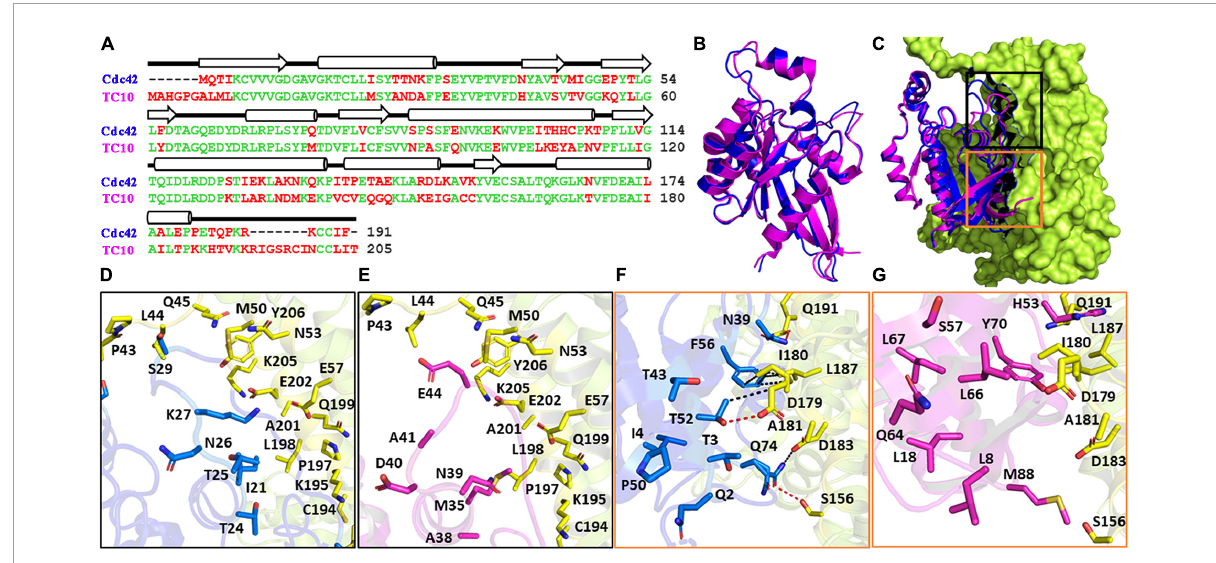
FIGURE1 Cdc42 and TC10 comparison. (A) Sequence alignment calculated with Clustal (Sievers et al., 2011) of murine TC10 and Cdc42. Conserved amino acid residues are displayed in green, diverging residues in red. On the top, β -strands (arrows) and α -helices (cylinders) are indicated. (B) Superimposition of Cdc42 (PDB entry 1an0; blue) and TC10 (PDB entry 2atx; magenta), highlighting their conserved three-dimensional structures. (C) Crystal structure of the Cdc42-CB2SH3 - complex (PDB entry 2dfk) superimposed with TC10 (PDB entry 2atx). TC10 (magenta) and Cdc42 (blue) are shown in cartoon, whereas CB2SH3 – (lemon) is depicted in surface representation. Black and orange boxes represent the top and bottom portion of the Cdc42-CB interface. (D,E) Zoomed image of the top interface region of the CB-Cdc42 complex (D) and the hypothetical CB-TC10 interface region following superimposition of TC10 onto Cdc42 (E) . Residues of Cdc42, which are part of the interface but are not conserved in TC10, are represented with their side chains in blue (D) and the corresponding residues of TC10 in magenta (E) . (F,G) Enlarged image of the bottom section of Cdc42-CB interface (F) and that of the hypothetical TC10-CB complex (G) . Residues are highlighted as described for panels (D,E) . Hydrogen bonds and hydrophobic interactions in the Cdc42-CB complex (F) are represented by red and black dotted lines,